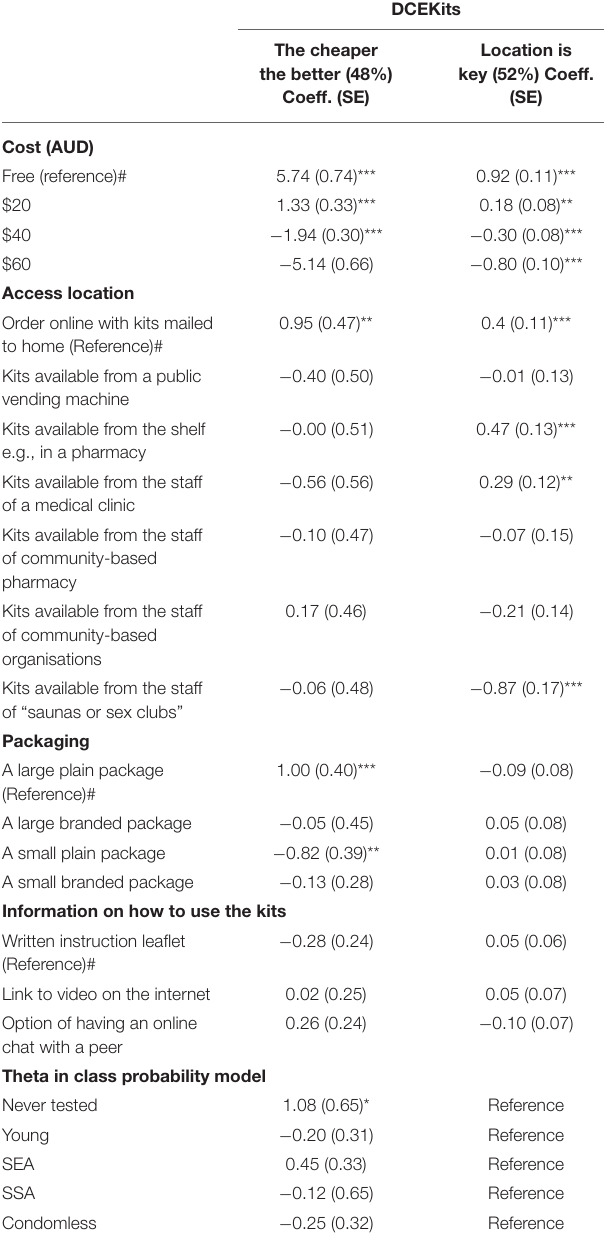
TABLE 5 | Latent class analysis of HIVST distribution preferences of Australian migrant men who have sex with men born in non-RHCA countries ( N =